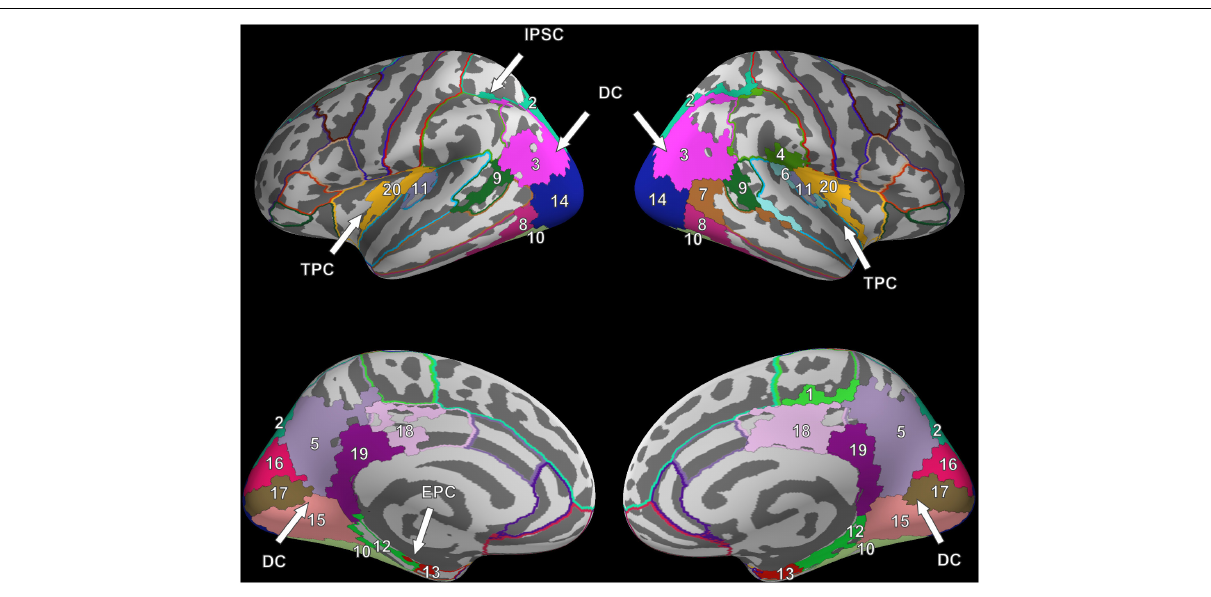
FIGURE 3 | Cluster results for the fixation onset contrast of image presentation during VS vs. fixation cross presentation. Separate ROIs according to the Desikan-Killiany atlas are highlighted in different colors (Desikan et al., 2006). The identified clusters (DC, dorsal cluster; TPC, temporoparietal cluster; IPSC, intraparietal sulcus cluster; EPC, entorhinal-parahippocampal cluster) are mostly symmetric across hemispheres. Corresponding ROI names are listed in Table 1